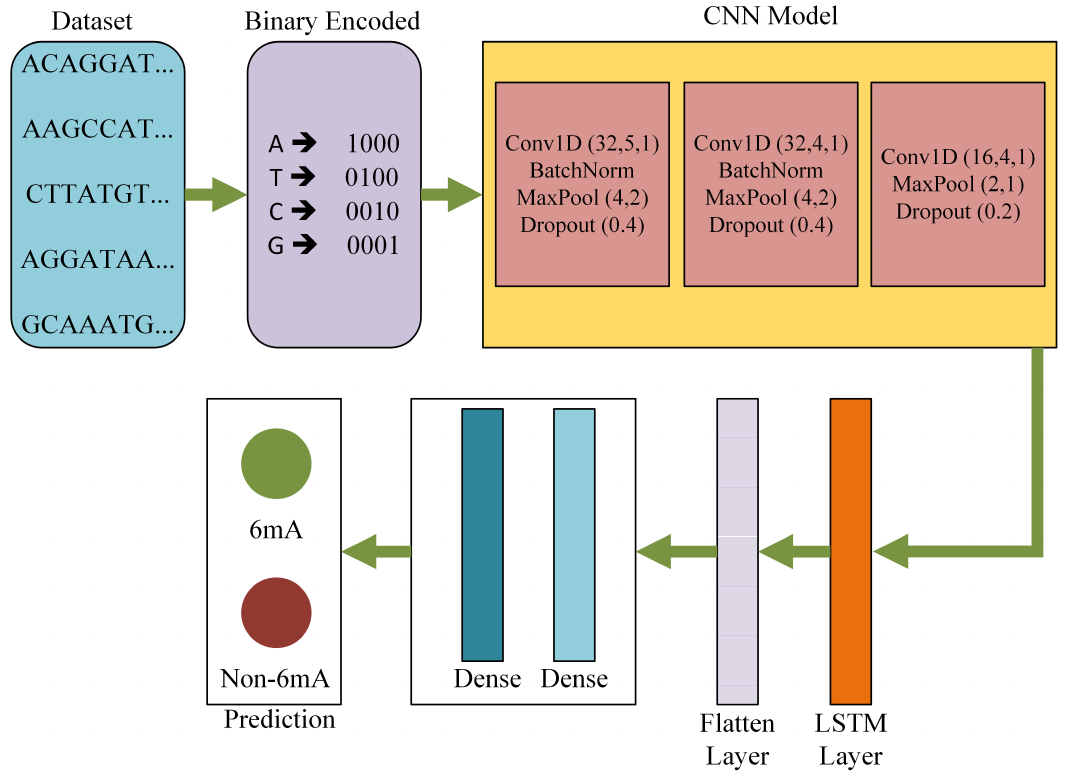
Figure 1. DNA6mA-MINT architecture for identification of DNA 6mA modification.